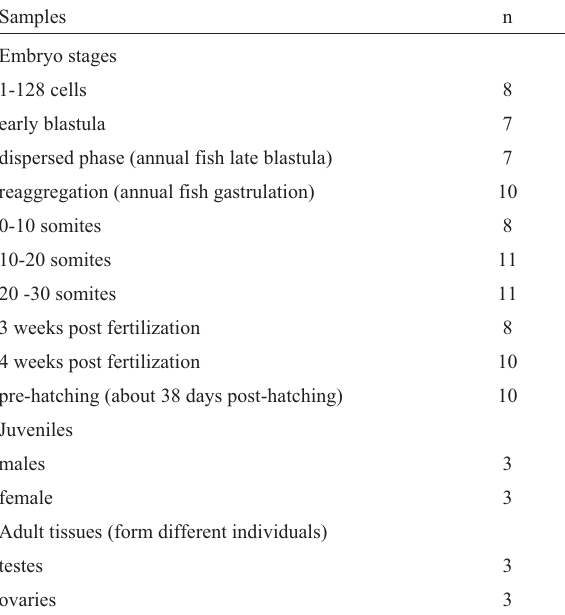
Table 1 - Samples used for RNA extraction.